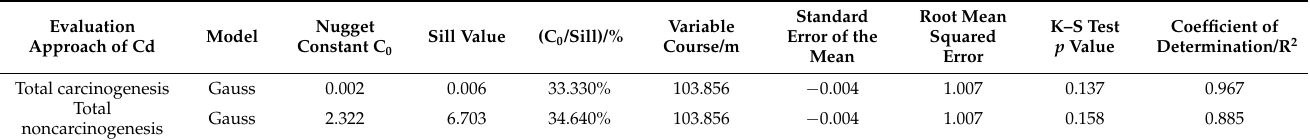
Table 7. Fitting results of the semivariogram